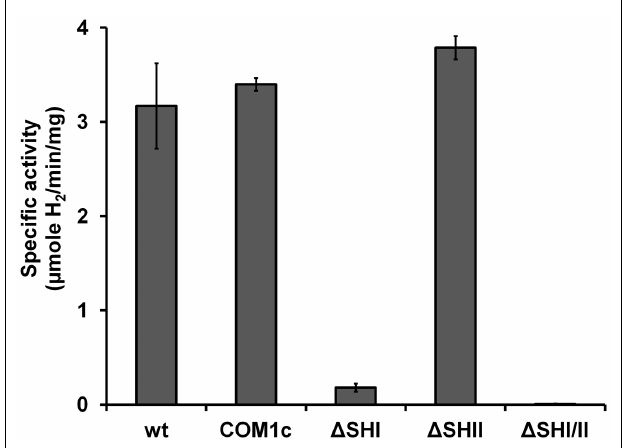
FIGURE 1 | Hydrogenase activity (using methyl viologen as electron carrier) in cytoplasmic fractions obtained from P. furiosus cultures of hydrogenase disruption mutants and parental strains. See Table 1 for strain definitions.